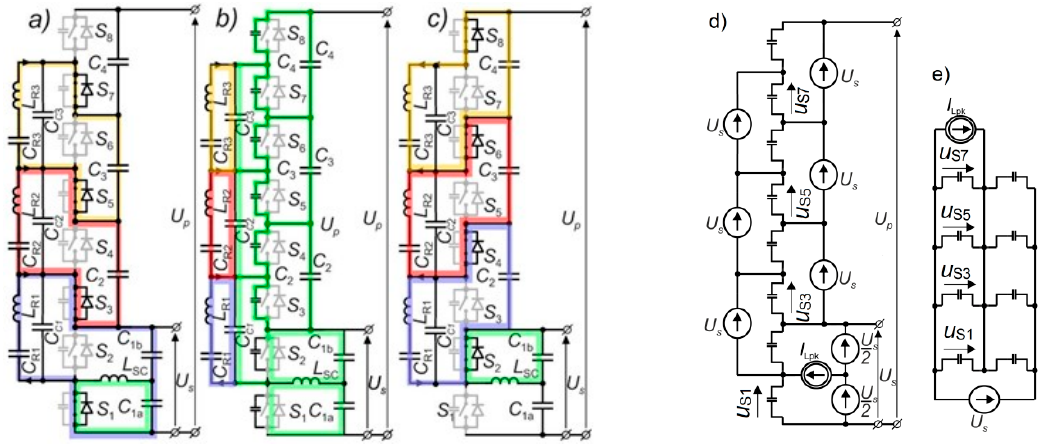
Figure 5. ( a – c ) The sequence of modes for commutation from odd to even switches in MRSCC with the commutation capacitors C Cn and the supporting inductor L SC ; ( d ) Simplified equivalent circuit for charging the C oss by L CS current during dead time (mode b); ( e ) further simplification.